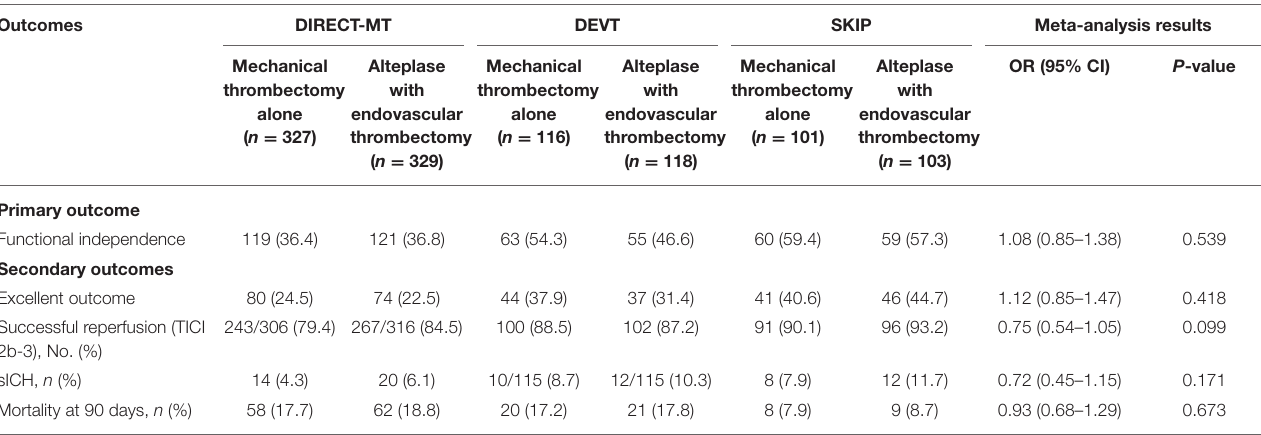
TABLE 4 | Summary of pooled analyses for primary and secondary outcomes.